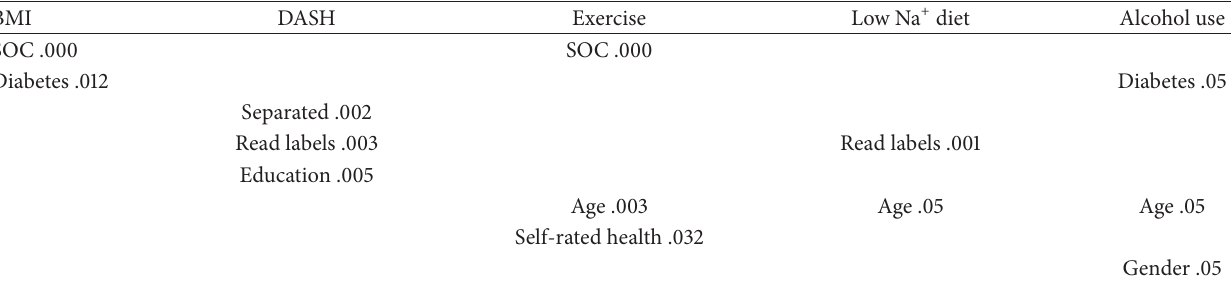
Table 6: Final predictors of engagement in